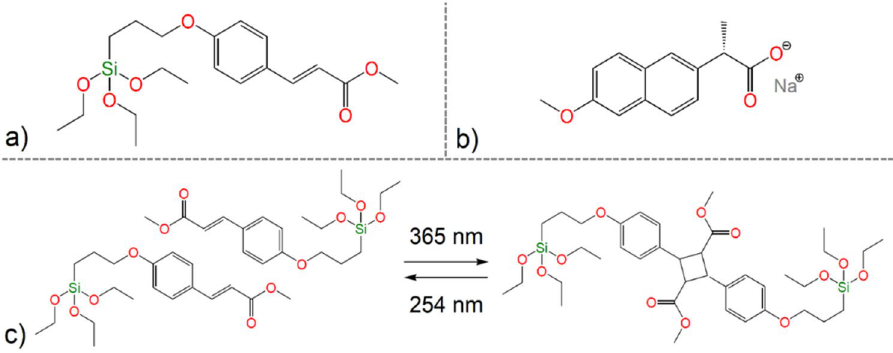
Figure 2. Molecular structure of ( a ) methyl-(2E)-3-(4-(triethoxysilyl)-propoxyphenyl)-2-propenoate (CA), ( b ) Naproxen sodium salt and ( c ) photo-dimerization/cleavage reaction of